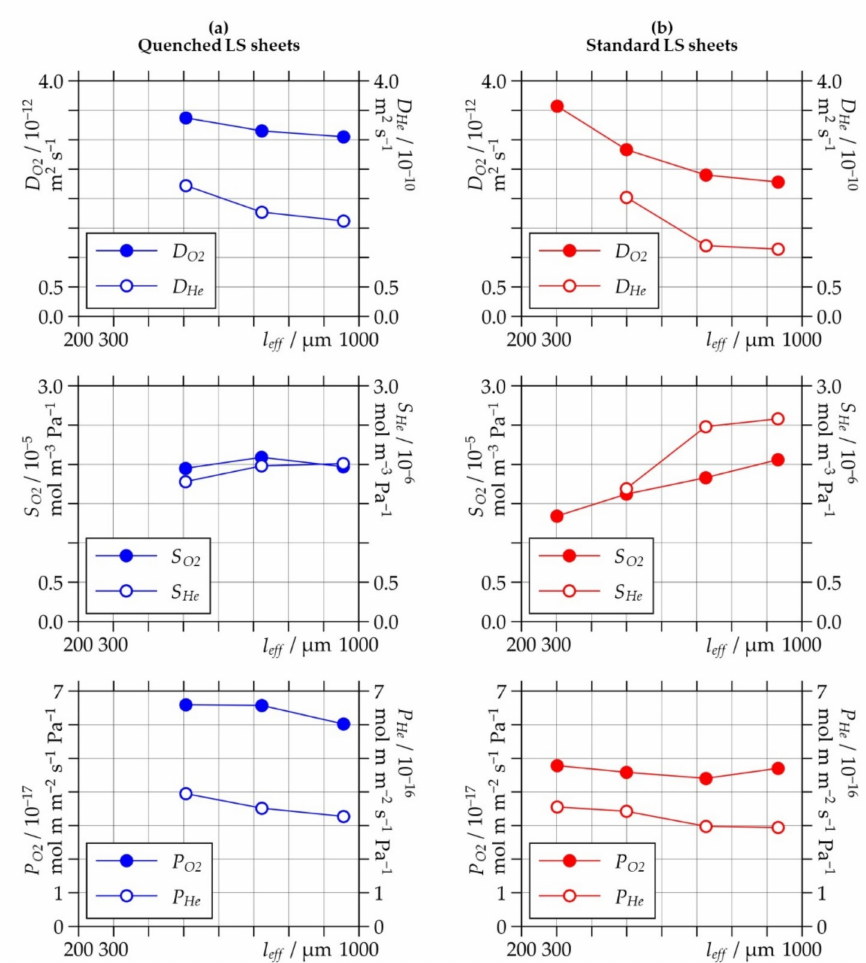
Figure 11. Oxygen and helium diffusion coefficients ( D O2 / D He ), solubility coefficients ( S O2 / S He ), and permeation coefficients ( P O2 / P He ) as a function of the effective thickness ( l eff ) of ( a ) quenched and ( b ) standard laser-sintered (LS) polyamide 12 sheets generated with two, four, six, and eight